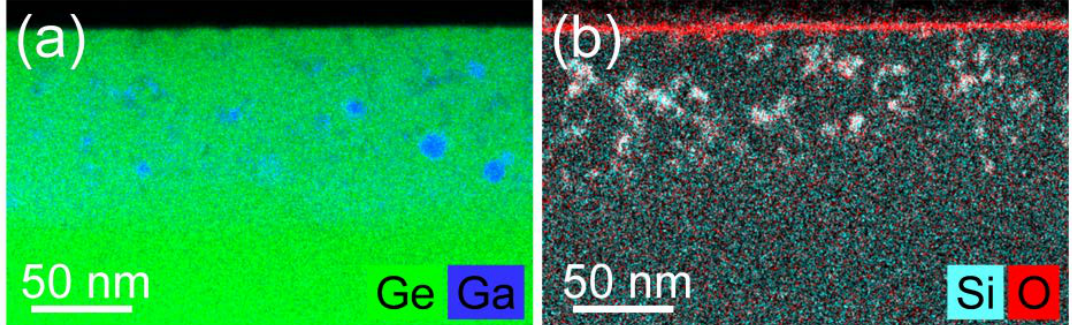
Figure 4. Depth distribution of Ga in Ge ( a ) and Si and O ( b ) in Ge heavily doped with Ga after ion implantation and flash lamp annealing. The elemental depth distributions are based on EDXS analysis in scanning TEM mode.